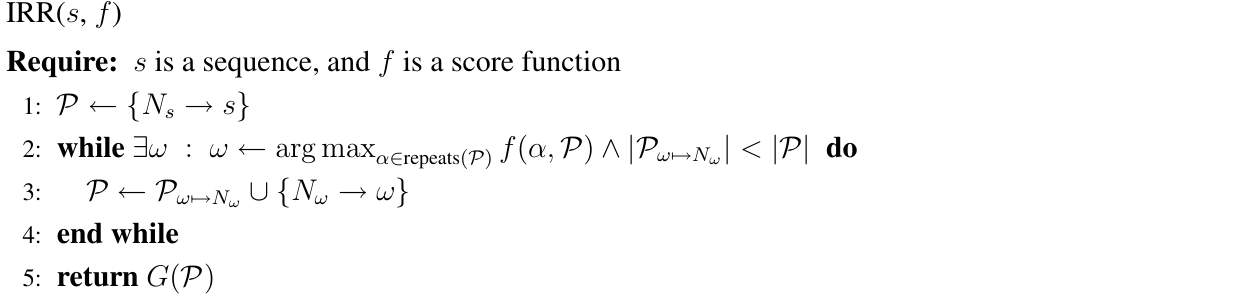
Algorithm 1 Iterative Repeat Replacement.